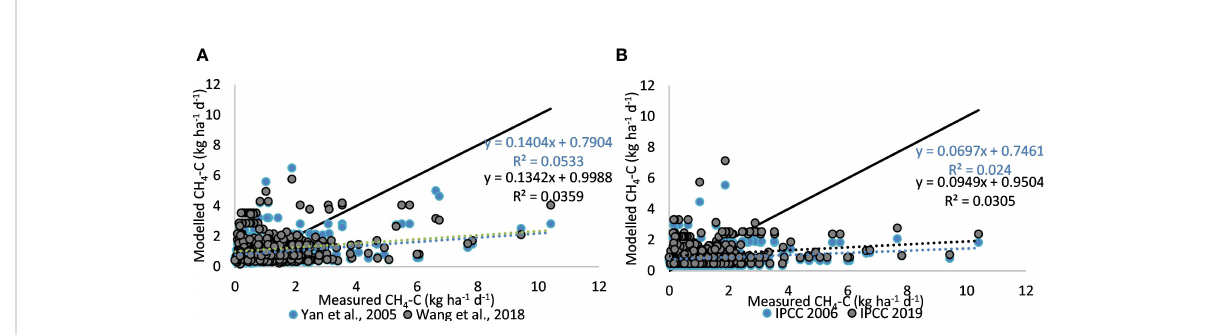
FIGURE 6 Modelled and observed CH 4 emission for East Asia: (A) Yan and Wang tier 3 models, (B) IPCC tier 1 models (solid line indicates 1:1). Sample number = 459 for tier 1 and 455 for tier 3